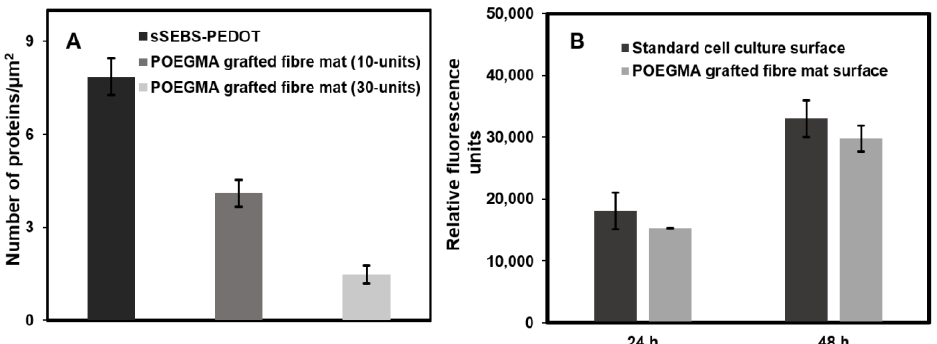
Figure 4. ( A ) The number of BSA proteins adsorbed on the grafted sSEBS-PEDOT/P(EDOT- co - EDOTBr)- g -POEGMA with 10- and 30-mers graft lengths and the sSEBS-PEDOT fibre mat, surfaces, after 2 h incubation in a solution of BSA in PBS (200 µg/mL); calculated as number per µm 2 of the projected area (n = 3). ( B ) The fluorescent signals obtained from the cells grown on the standard cell culture plate and POEGMA grafted fibre mat surface.